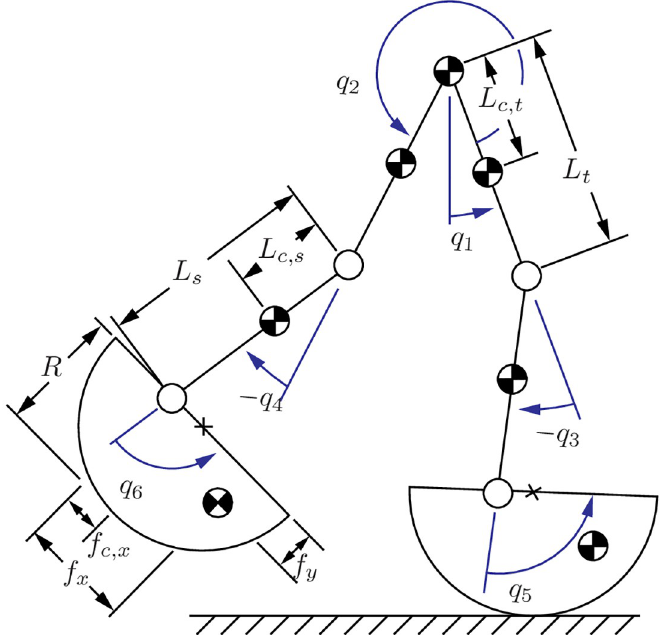
Fig 1. Six link biped model. The unactuated angle is q 1 and the actuated angles are q 2 ... q 6 .